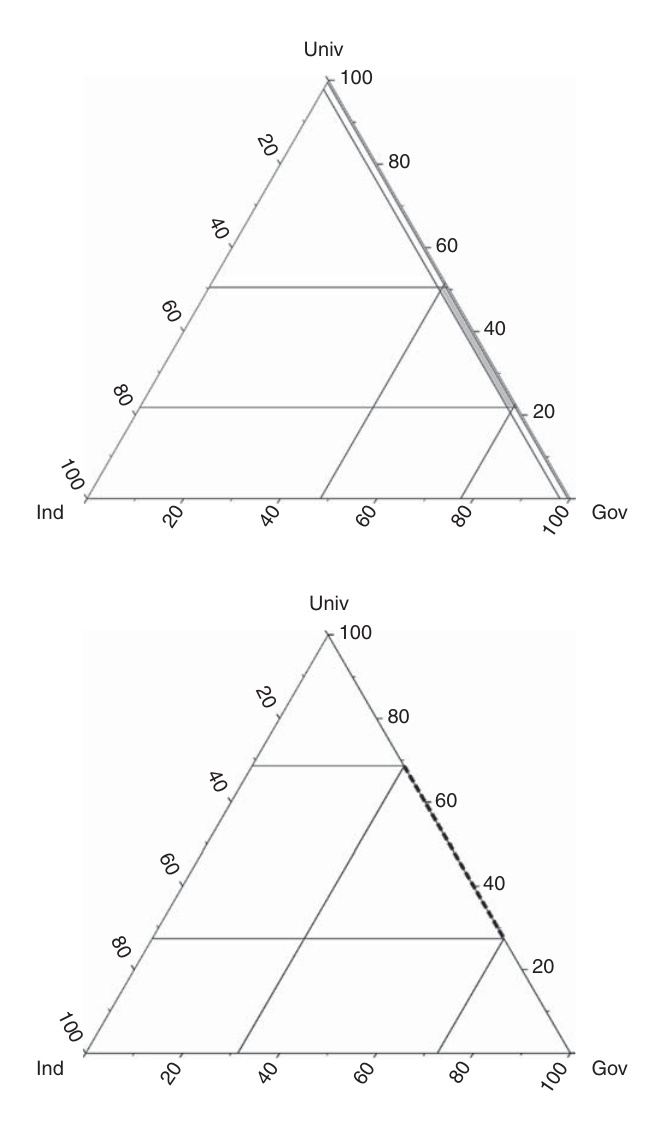
Figure 7. Core of